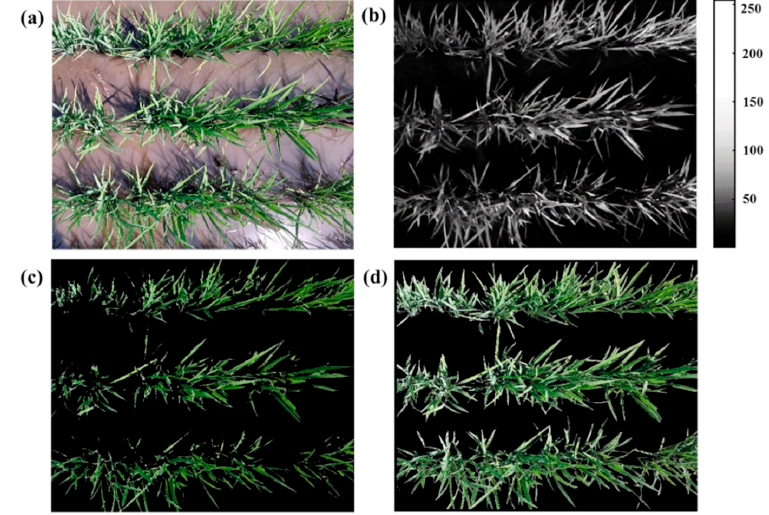
Figure 2. Images of the rice canopy captured by a smartphone and the same images after segmentation: ( a ) original image, ( b ) green channel minus red channel (GMR) value and ( c , d ) segmented rice canopy images with GMR thresholds of 30 and 10, respectively.